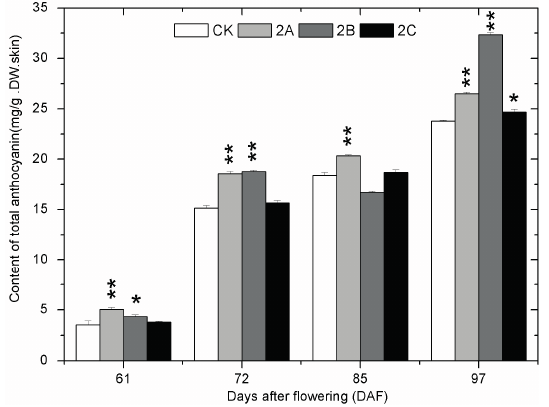
Figure 4. The change of total anthocyanins content in grape skin with developmental stages in the control and Zn-treated groups in 2013. The asterisk represents the content in the zinc treatment group is significantly different than the control group at 1% level (for two asterisks) and 5% level (for one asterisk),